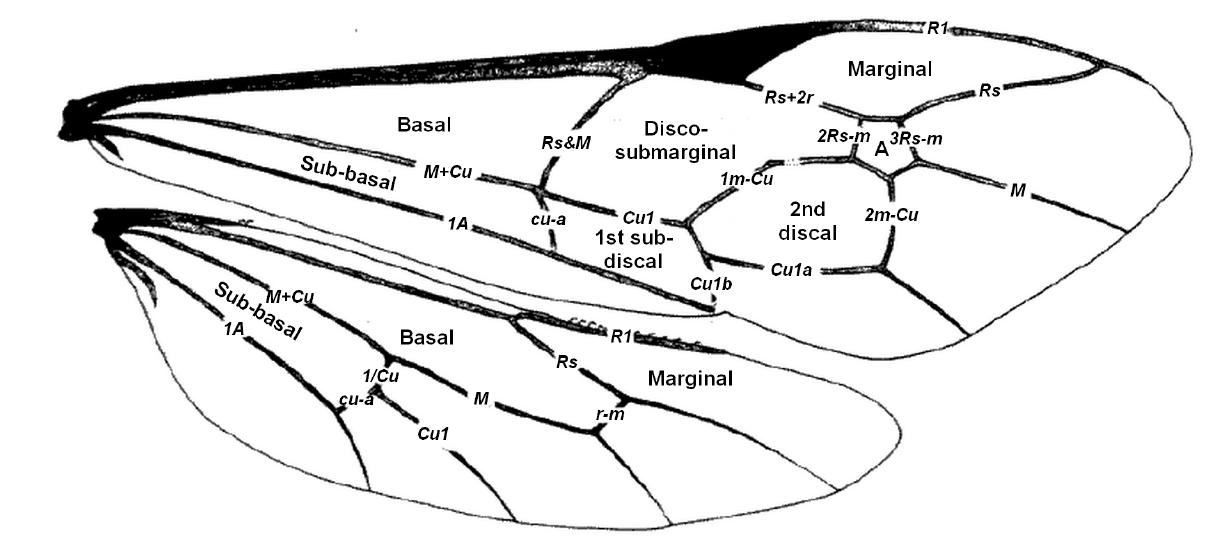
Fig. 1. Wing venation nomenclature (Gauld